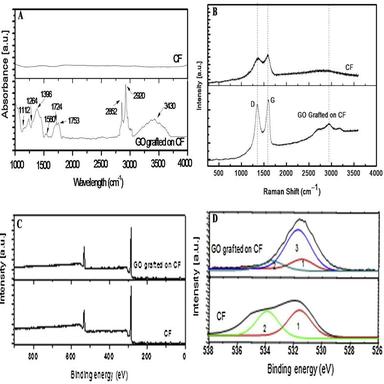
(A) FTIR spectra of CF and GO grafted on CF samples (B) Raman spectra of CF and GO grafted on CF samples (C) XPS wide scan spectra and (D) Curve fitting of O1s peak area of surface functional groups.